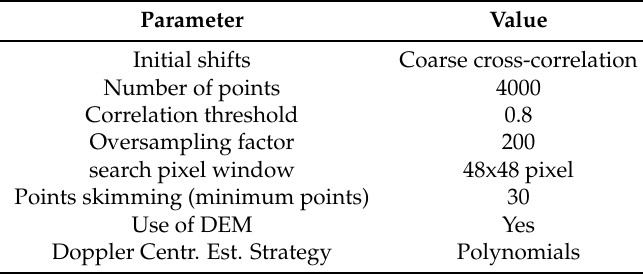
Table 2. Coregistration